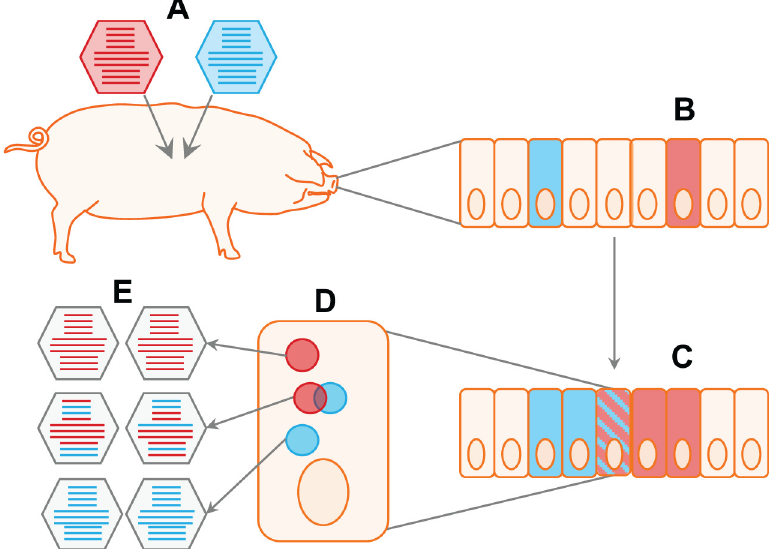
Fig 1. Reassortment requires viruses to meet on multiple scales. For reassortment to occur between viruses of two distinct genotypes, these viruses must infect the same host (A) and the same tissue within that host (B). Either the inoculating viruses or their progeny must come together within the same cell (C). Finally, the coinfecting viral genomes must mix within the coinfected cell, and replicated segments must be copackaged, processes which may be limited by compartmentalization of viral replication and selectivity of genome incorporation, respectively (D). When all of these criteria are met, progeny viruses of both reassortant and parental viral genotypes will emerge from the cell